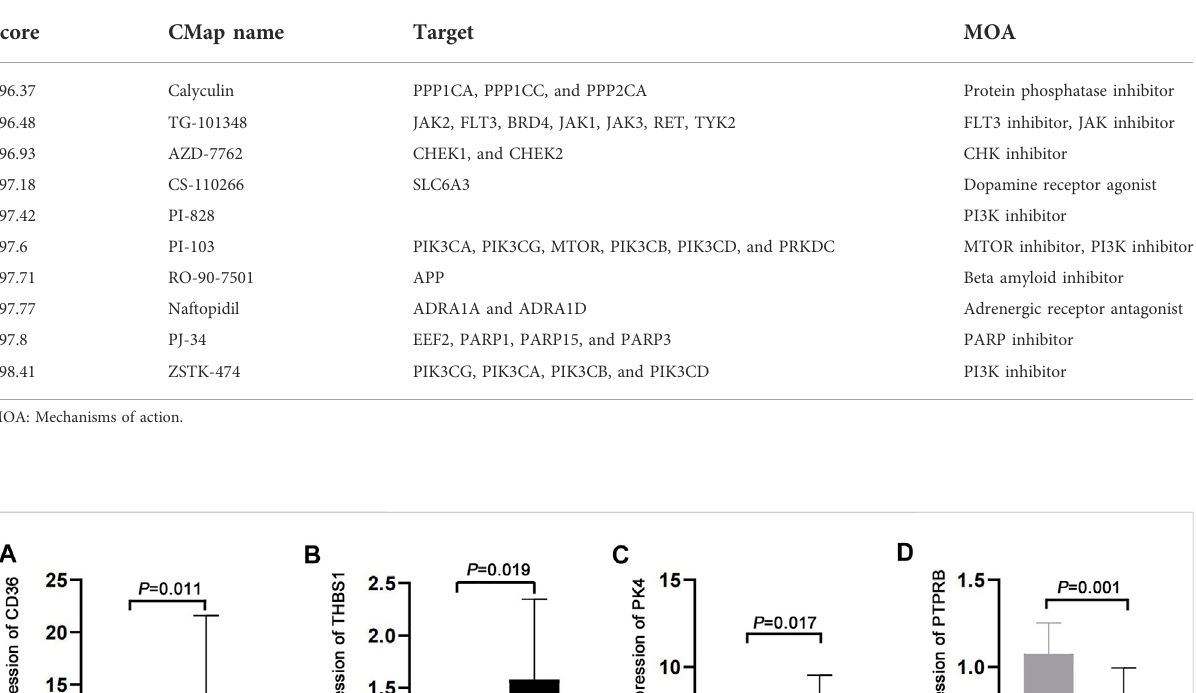
TABLE 1 Ten most negatively correlated small-molecule compounds screened from the CMap database.